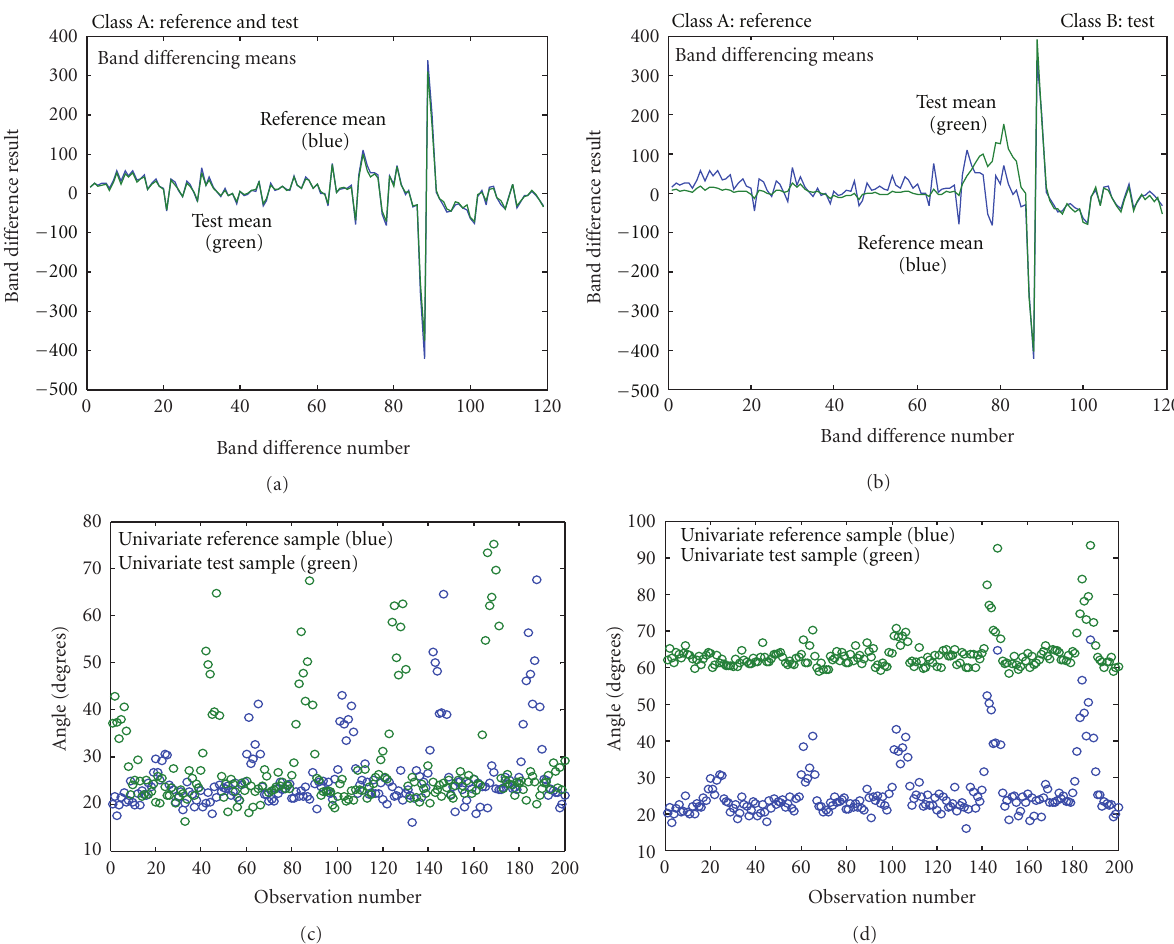
Figure 4: Spectral transformation from a multivariate to univariate sample using spectral di ff